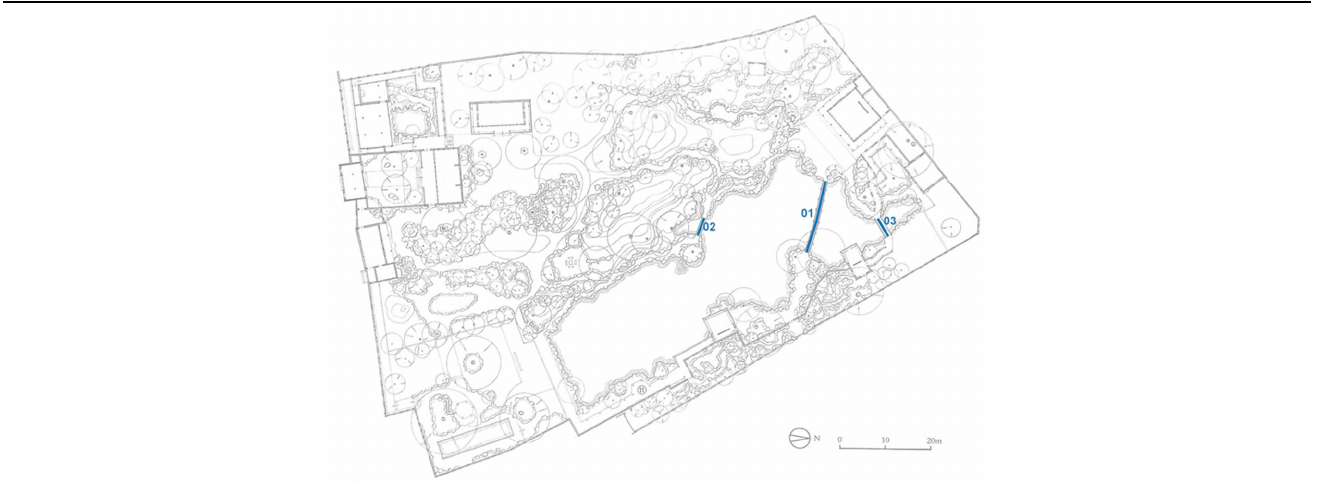
Table A28. Jichang Garden, bridge.